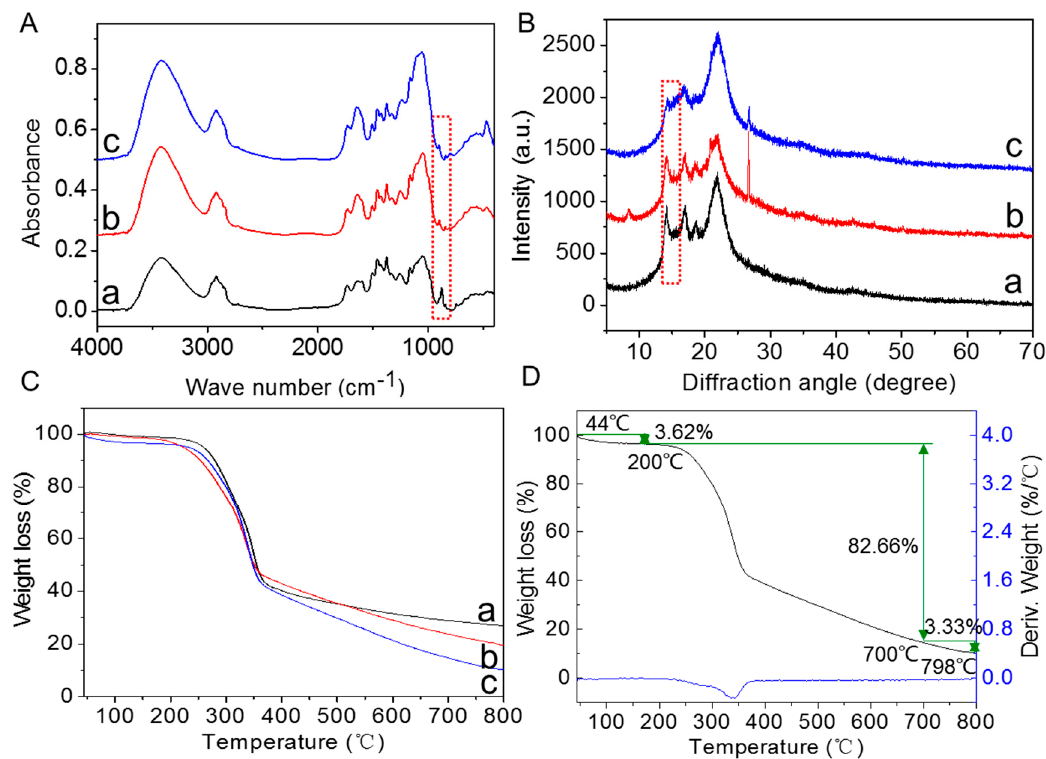
Figure 8. ( A ) Fourier transform infrared (FTIR), ( B ) XRD, and ( C ) thermal gravimetric (TG) spectra of ( a ) wheat straw, ( b ) BM-treated wheat straw, and ( c ) SRA-treated wheat straw after treatment for 100 d, ( D ) TG (black) and differential thermal (DT) (blue) curves of SRA-treated wheat straw.